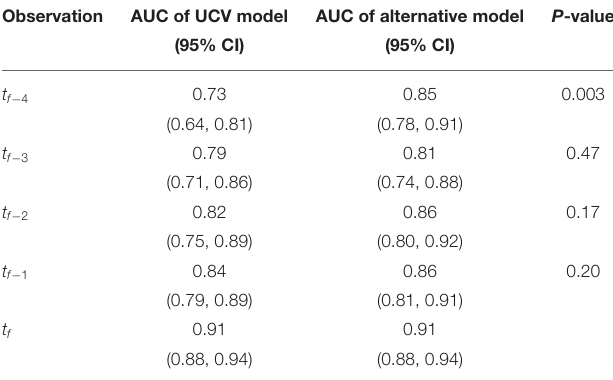
TABLE 2 | AUCs for each alternative model evaluated at the time of training via leave-one-out cross-validation (LOOCV) and statistical comparison with the UCV